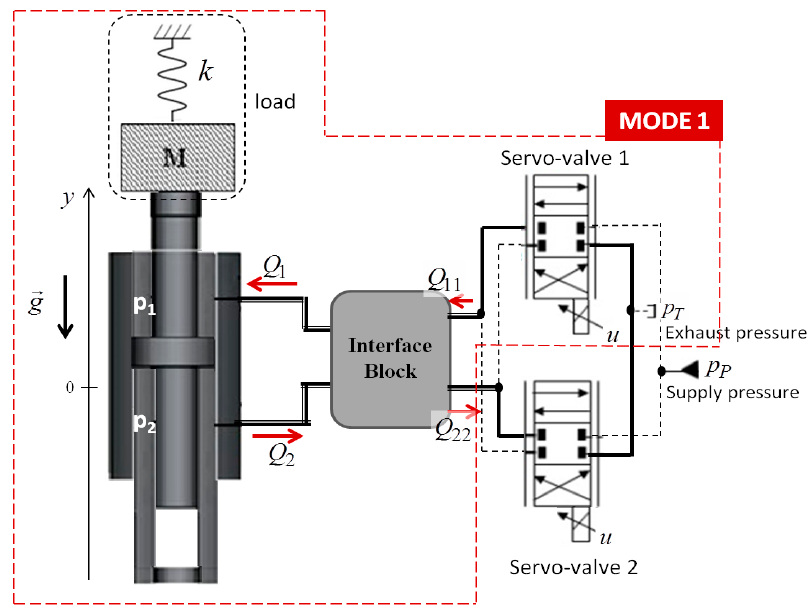
Figure 1. The schematic diagram of the hydraulic system.